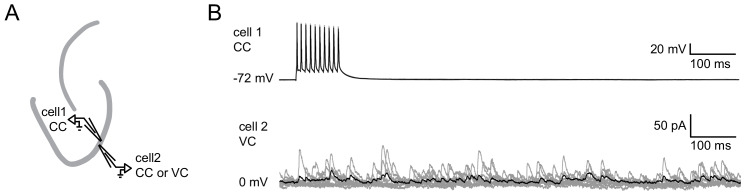
Absence of single GC induced feedback inhibition.Pairs of juxtaposed GCs (<100 µm distance) were recorded to test for single GC induced feedback inhibition. (A) Schematic illustration of the experimental setup. (B) Example of a paired recording where cell one is fired at 100 Hz in current clamp mode while cell two is recorded in voltage clamp mode in order to detect IPSCs. (gray, 10 individual trials; black, average).